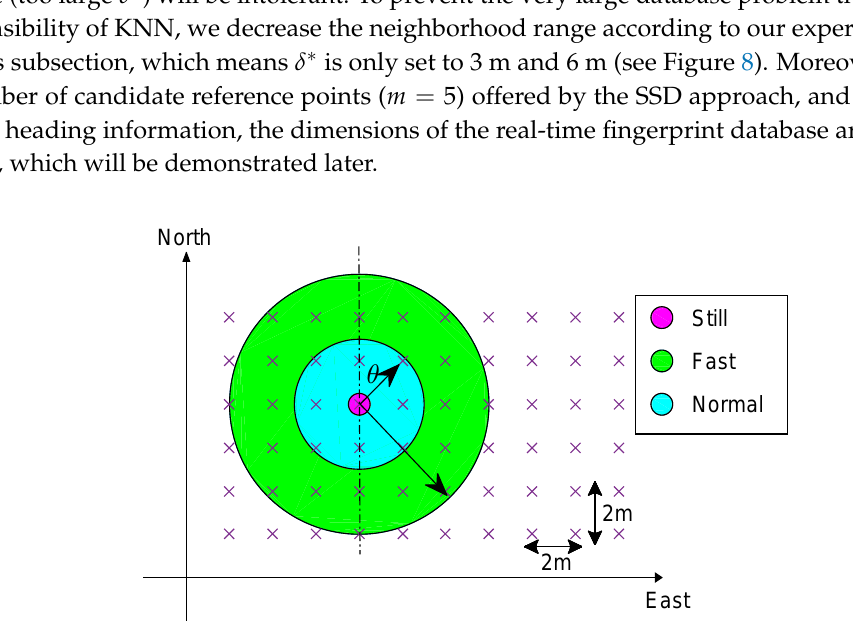
Figure 8. An example of the construction of a pairwise RSS fingerprint database associated with the topological information. Three types of topological information are demonstrated for the still, fast, and normal modes. Please note that we set the grid length to an average of 2 m in accordance with the general performance of fingerprinting-based positioning